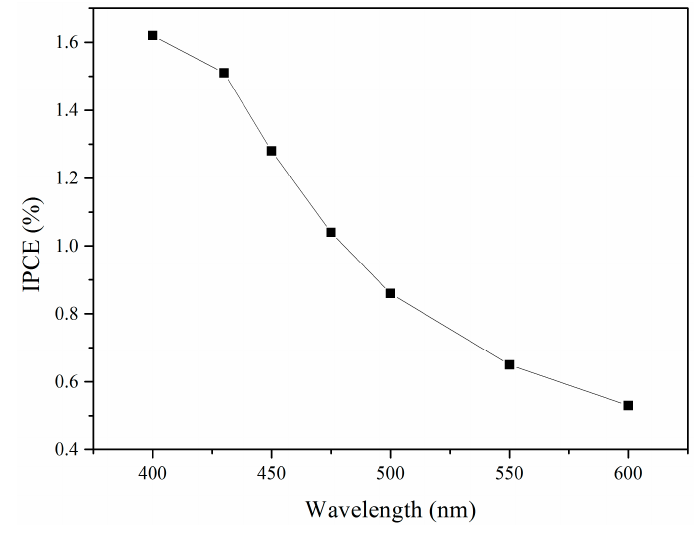
Figure 10. IPCE spectrum of the 0.05BiTNT-based solar cell, as captured at the incident wavelengths ranging from 400 to 600 nm. Table 1. Photovoltaic characteristics of the Bi 2 O 3 sensitized TiO 2 -based solar cells.